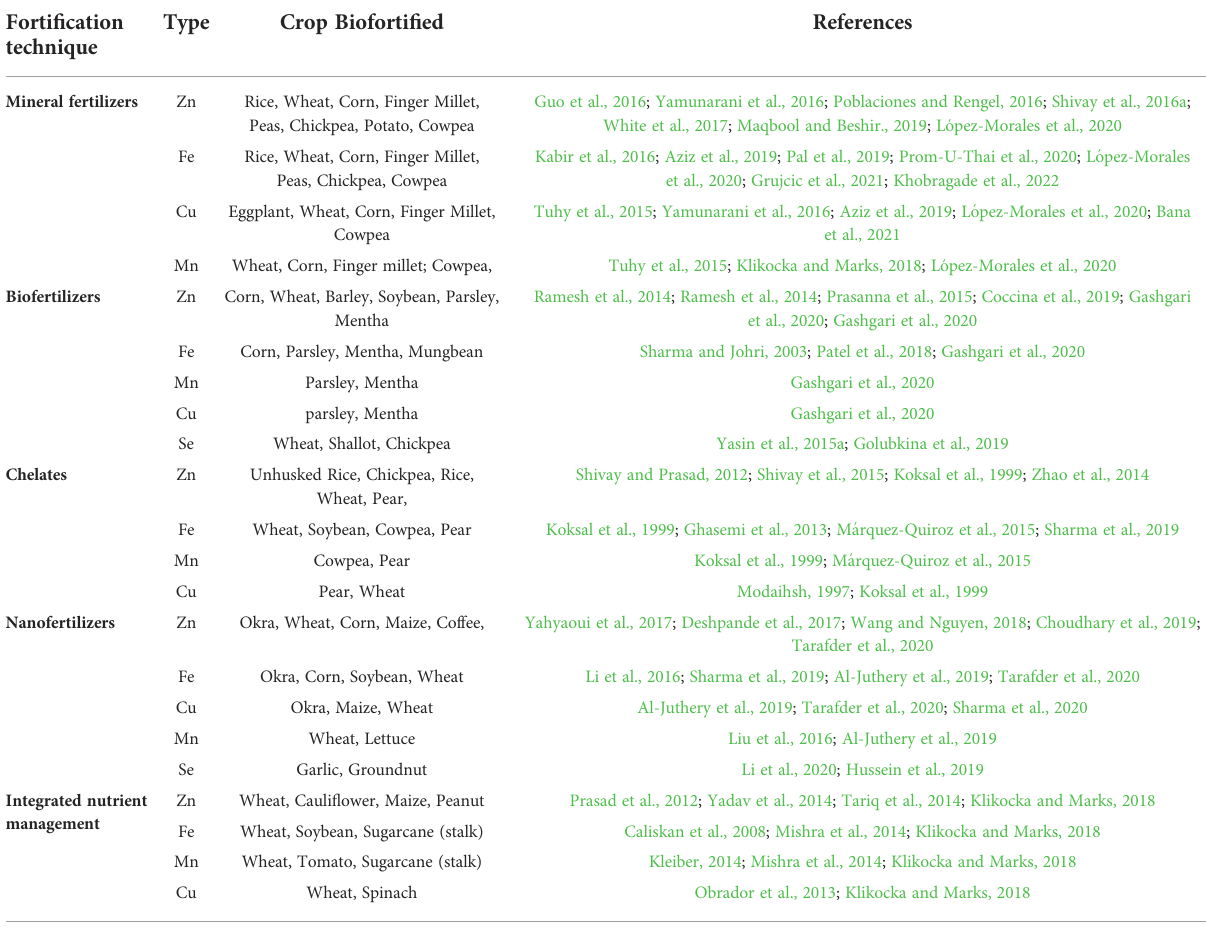
TABLE 2 Advanced fertilizer forms and techniques that have been successfully used for major mineral micronutrients in different